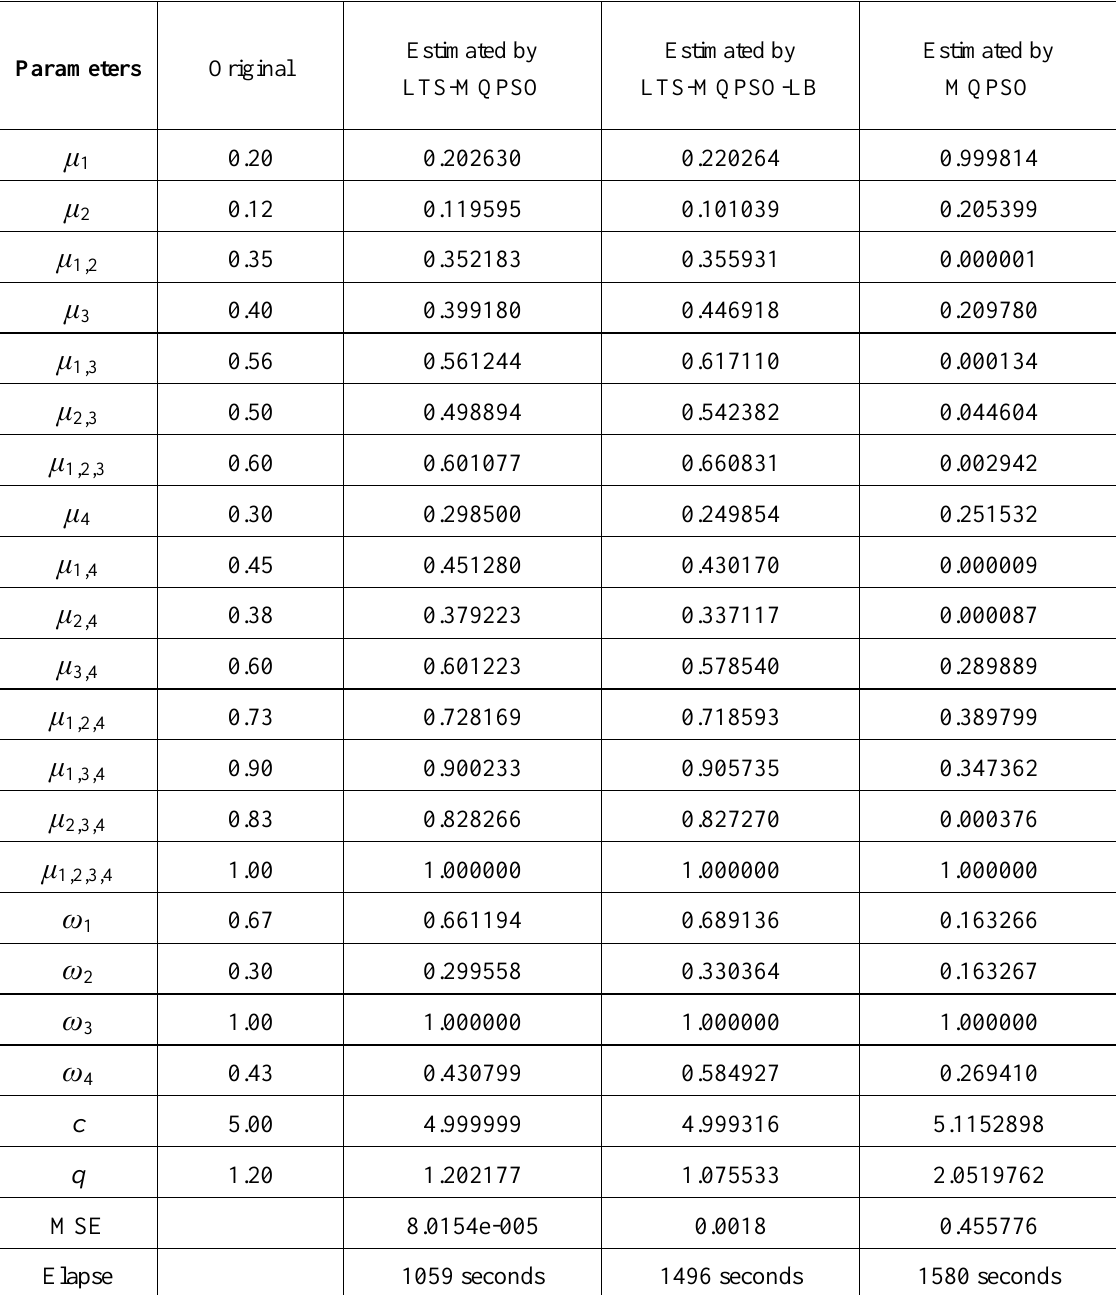
Table 4. The average results of model parameters estimated by the LTS-MQPSO, the LTS-MQPSO-LB and the MQPSO